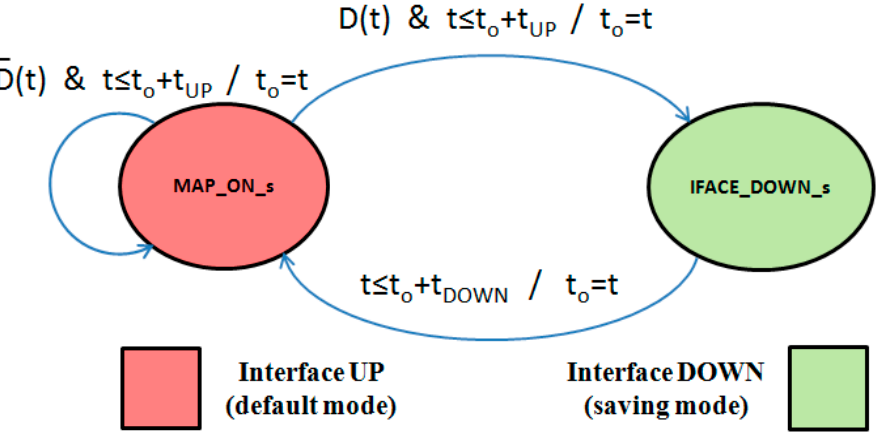
Figure 3. State diagram for our proposal.